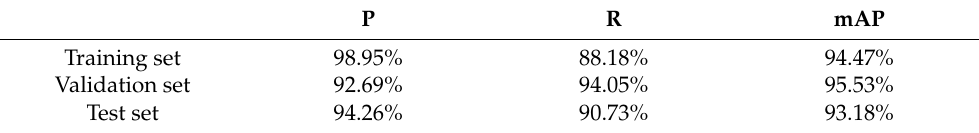
Table 1. Various indicators.